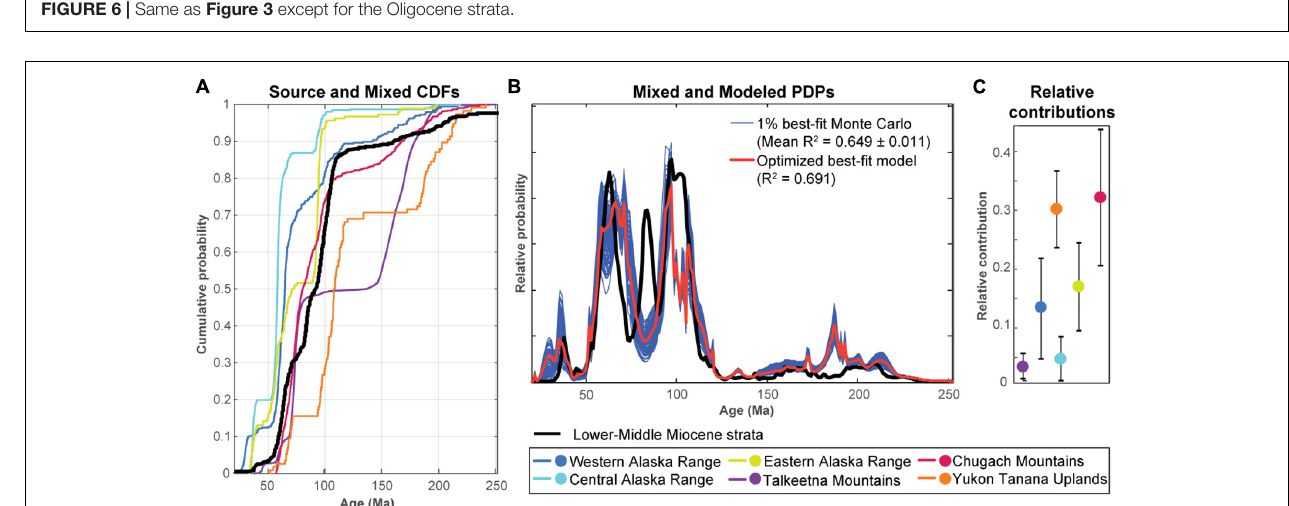
FIGURE 7 | Same as Figure 3 except for the Lower-Middle Miocene